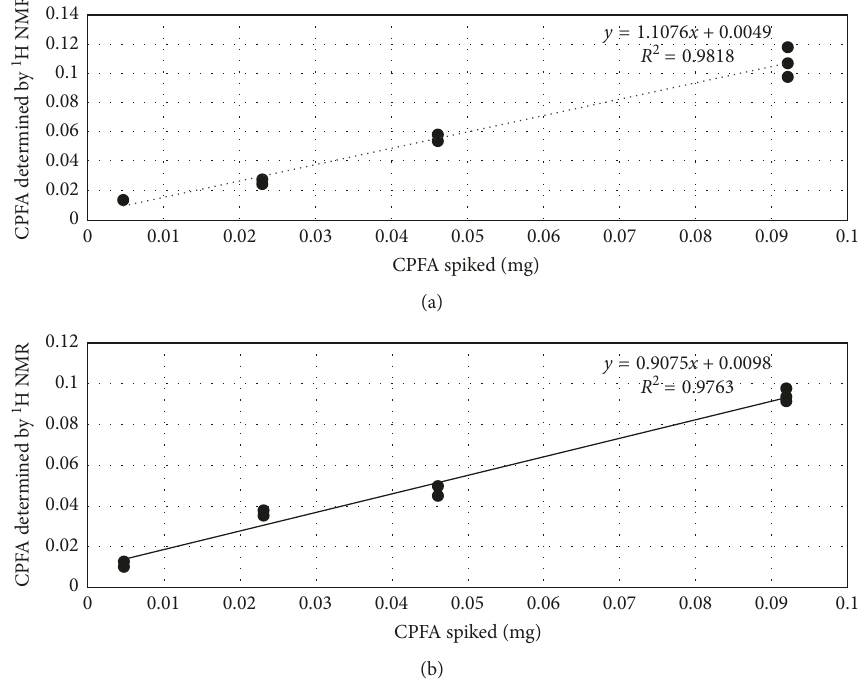
Figure 4: Calibration curves of CPFA spiked matrices: (a) cheese and (b) chicken